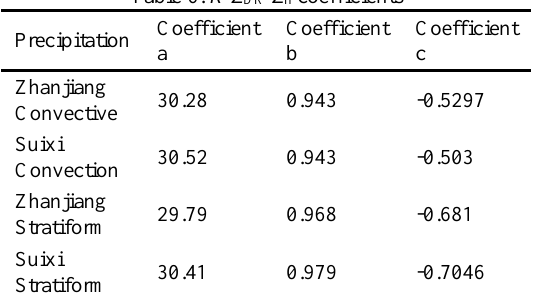
Table 6. R - Z DR - Z h coefficients